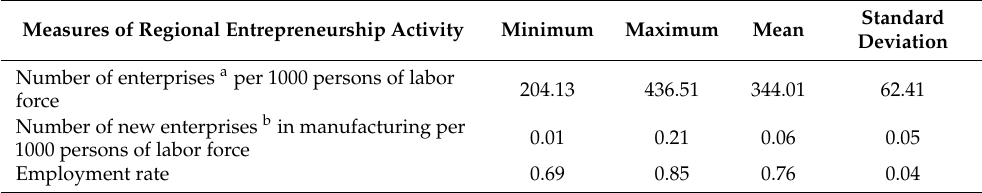
Table 1. Descriptive statistics of the individual measures of regional entrepreneurship